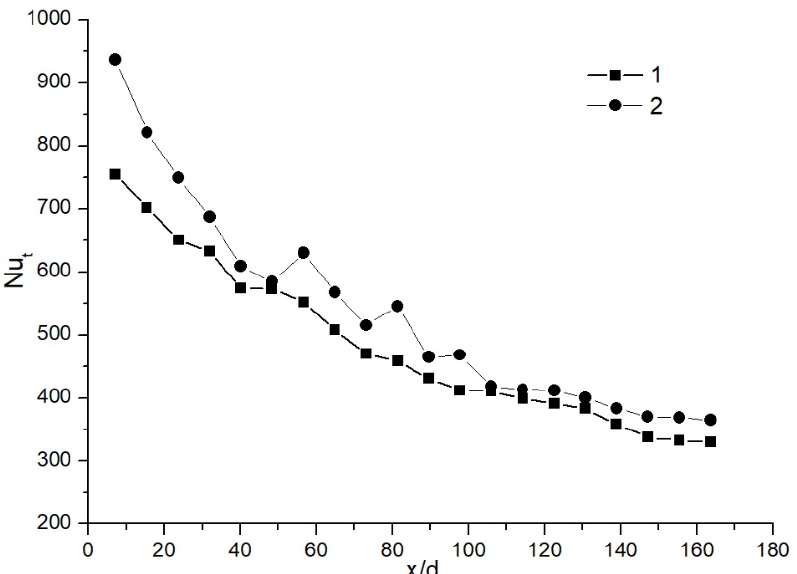
Figure 7. Distribution of the total local Nusselt number along the model of the condensing heat exchanger at Re in ≈ 9500, different flue gas inlet temperatures and for the case when water was injected into the flue gas flow: (1) t in ≈ 88 °C, (2) t in ≈ 125 °C.